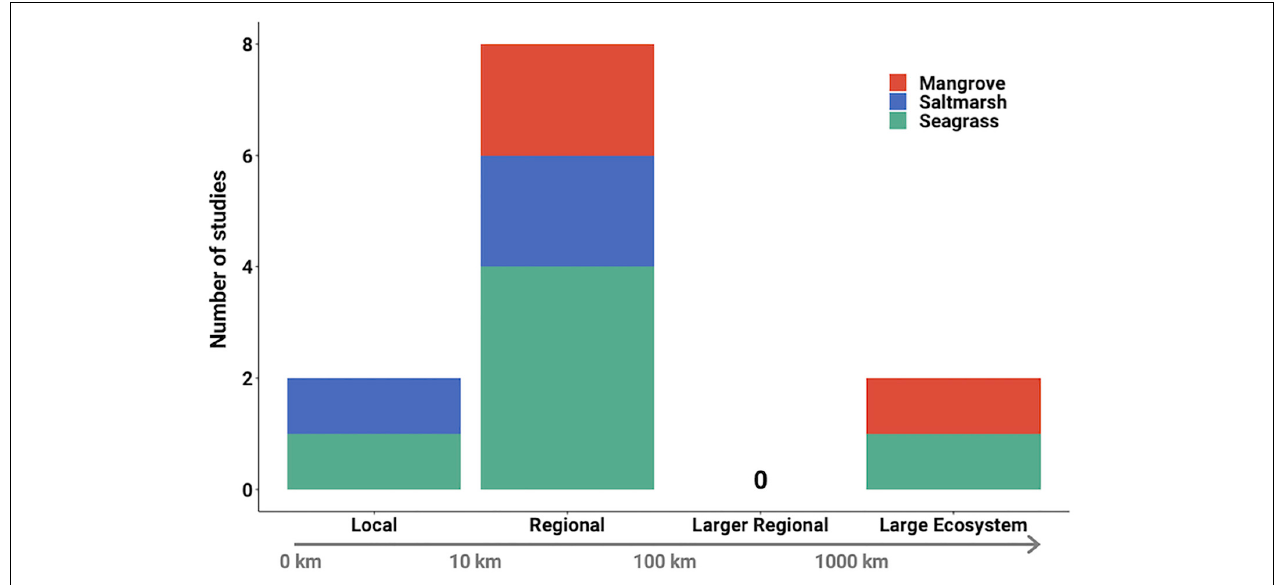
FIGURE 1 | Spatial scale of spatial planning restoration studies ( n = 12 because scale was not applicable in one modeling study).